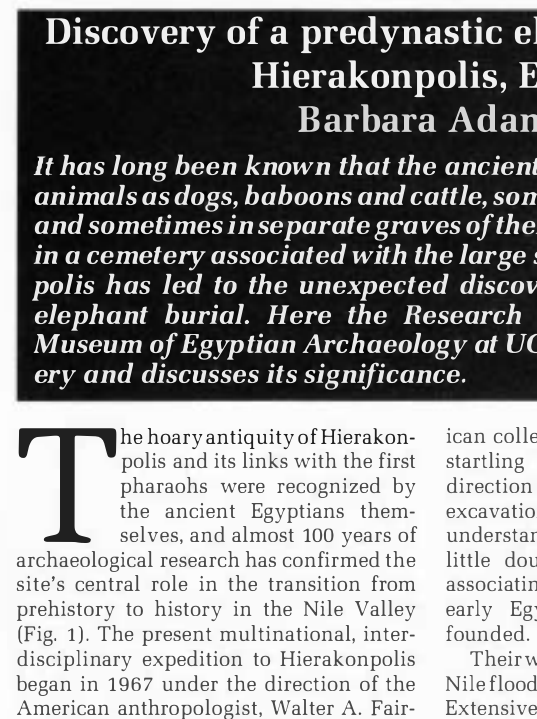
Figure 1 Upper and Lower Egypt, show­